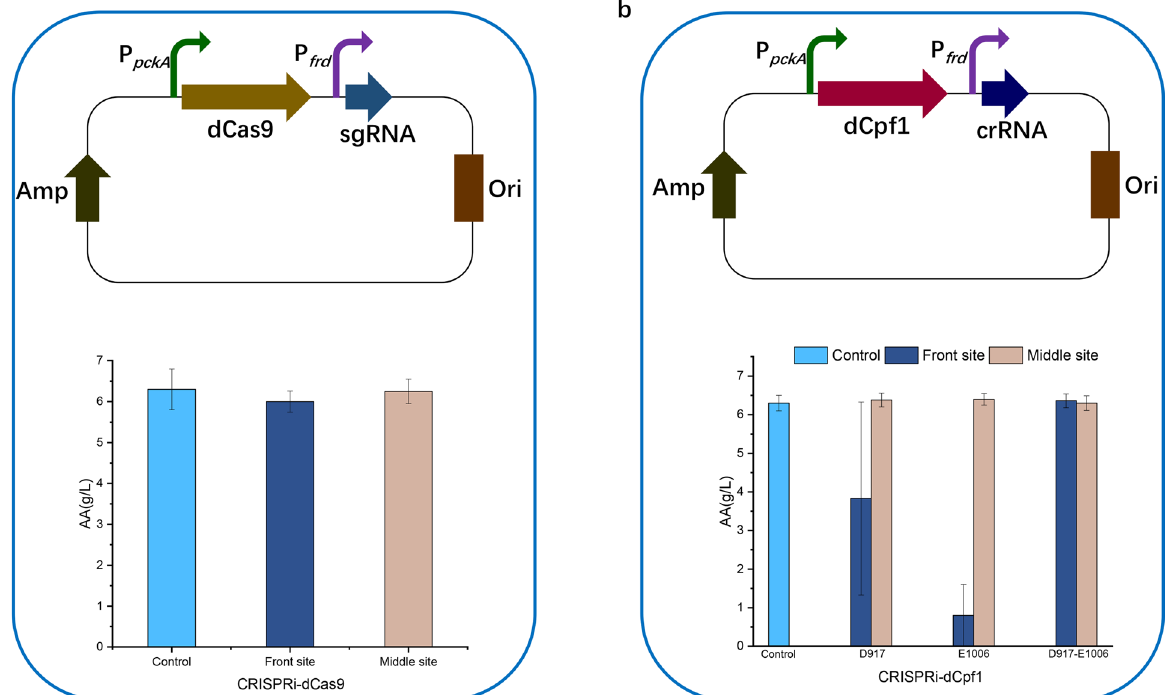
Fig. 3 Effects of dCas9 CRISPRi system ( a ) and dCpf1 CRISPRi system ( b ) on acetic acid (AA) production. AA production was measured after fermentation for 48 h. Results are the means of at least three independent assays and error bars indicate the standard